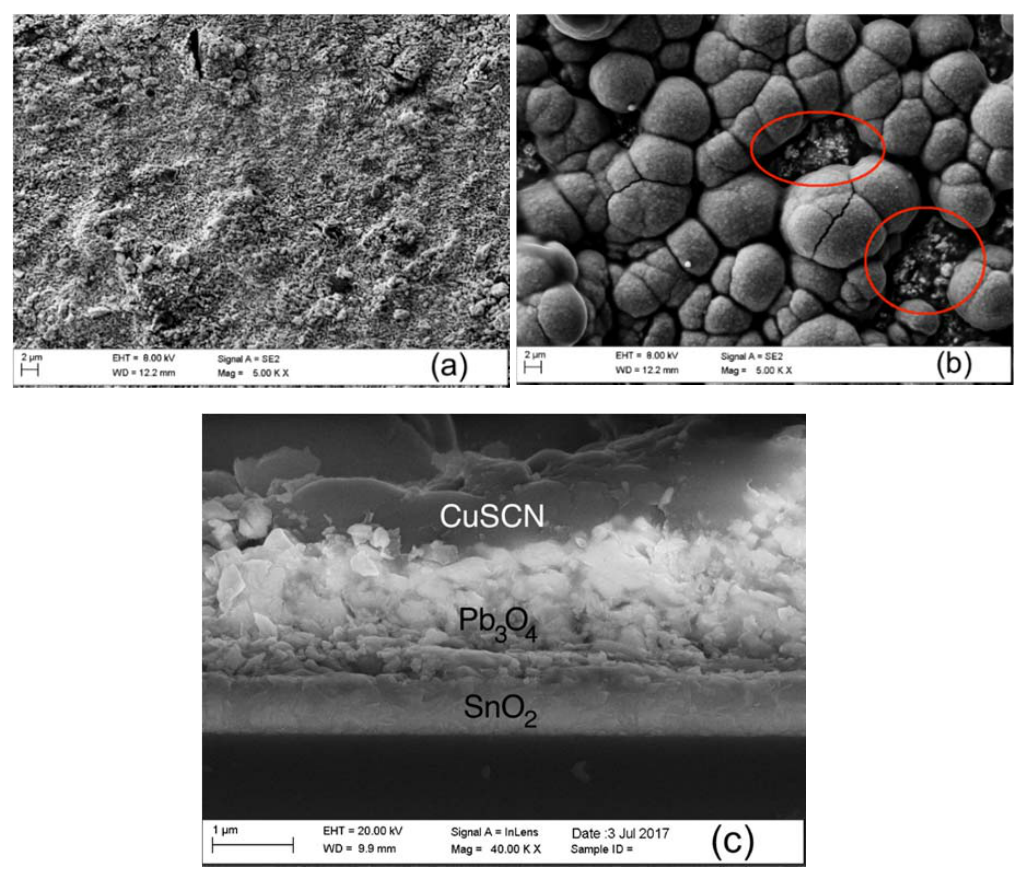
Figure 4. ( a ) SEM image of the Pb 3 O 4 film; ( b ) SEM image of CuSCN film; ( c ) SEM image of a cross section of the heterojunction.